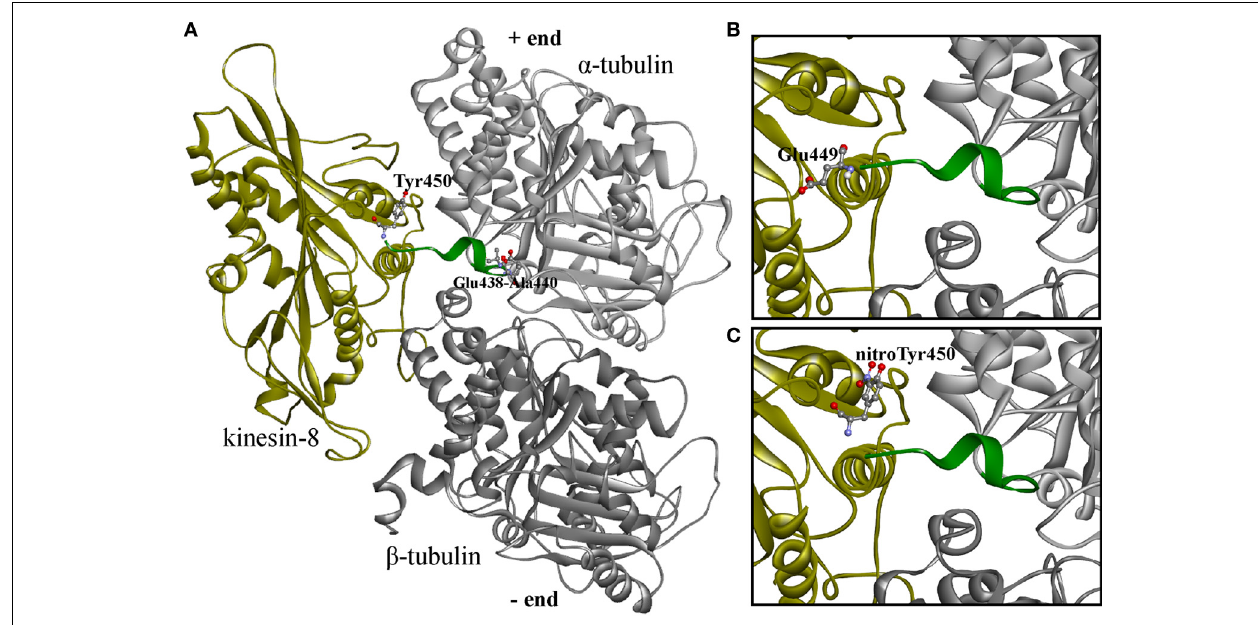
α -tubulin. Proteins shown as ribbons, amino acid residues—as balls and sticks colored by elements. Last 15 (14) residues colored by green are labeled terminated residues and residues with changed torsion angles.